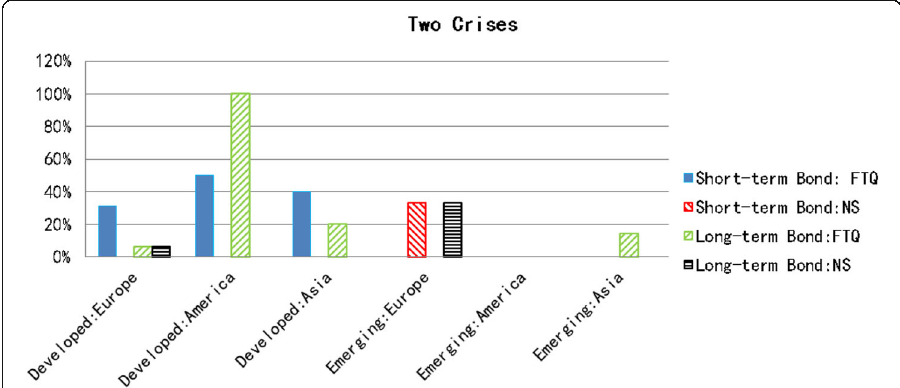
Table 1: the characteristics of different types of interdependence are summarized in Table 5 and Fig. 1. There is neither a flight from quality (FFQ) nor positive spillover (PS) shown in Table 6, which proves that Hypothesis 2 is